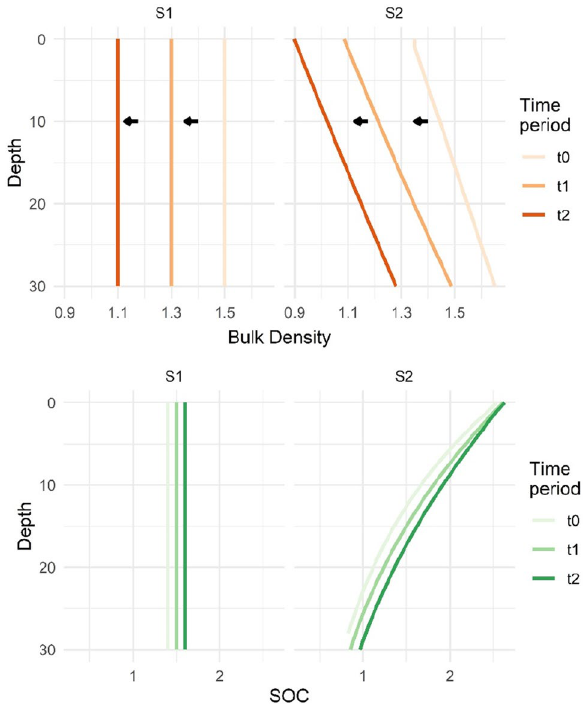
Figure 3. Scenarios (S1 and S2), showing ( a ) bulk density variation (BD, g cm −3 ), and ( b ) soil organic carbon (SOC, %) variation by depth (0–30 cm) at each time point (t0, t1, and t2). For scenario 2, the single 30 cm depth interval was used (2c). See Table 1 and 2 for